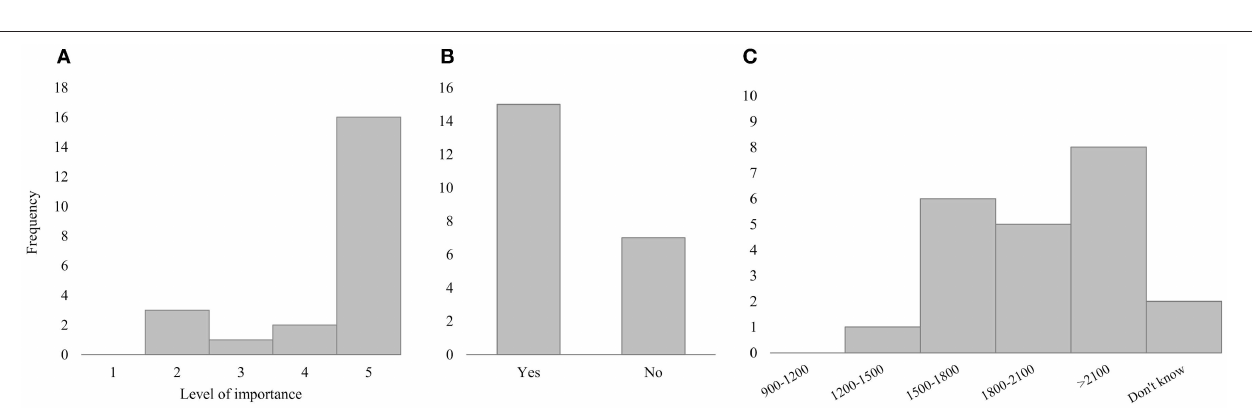
FIGURE 6 | Farmer’s responses to questions about perceptions of production costs and profitability from 22 farmers in Ferreñafe, Peru. (A) Farmer’s responses to the importance of low production costs for profitability: 1 = not important, 2 = low importance, 3 = neutral, 4 = important, 5 = very important. (B) Farmer’s responses (yes or no) to whether they know how much they spend per hectare during the growing season. (C) Farmers response to how much they should spend to maximize profit and